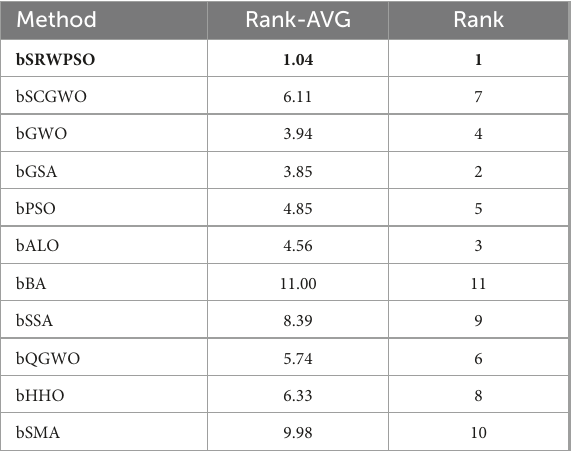
TABLE 18 The results of Friedman ranking for